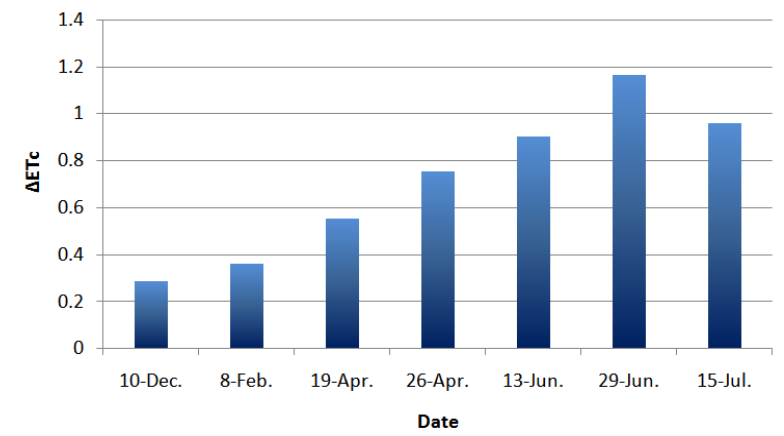
Figure 15. Temporal analysis of ∆ET the analytical approach for 10 (1ha) samples (3 pixels × 3 pixels) during the 2012–2013 growing